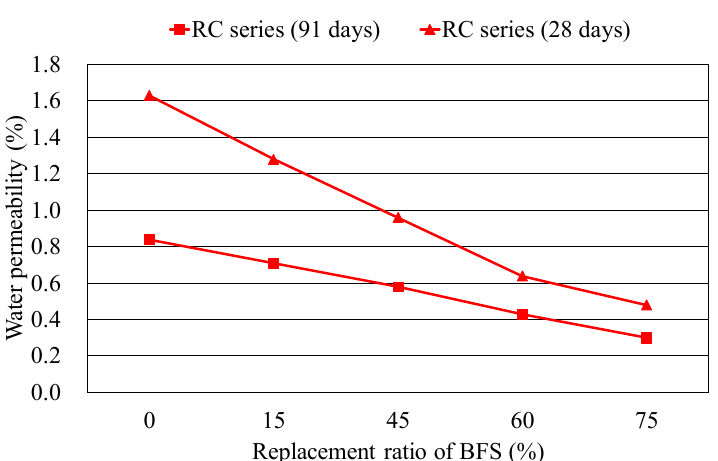
Figure 8. Influence of BFS content on the water permeability of RAC mixtures.